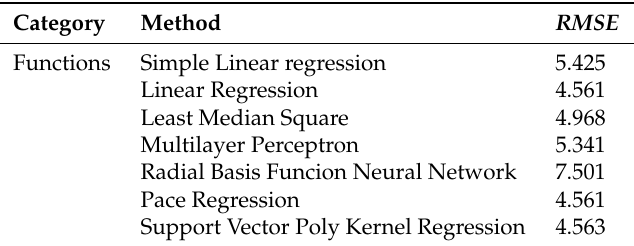
Table 1. Overview of methods and achieved RMSE